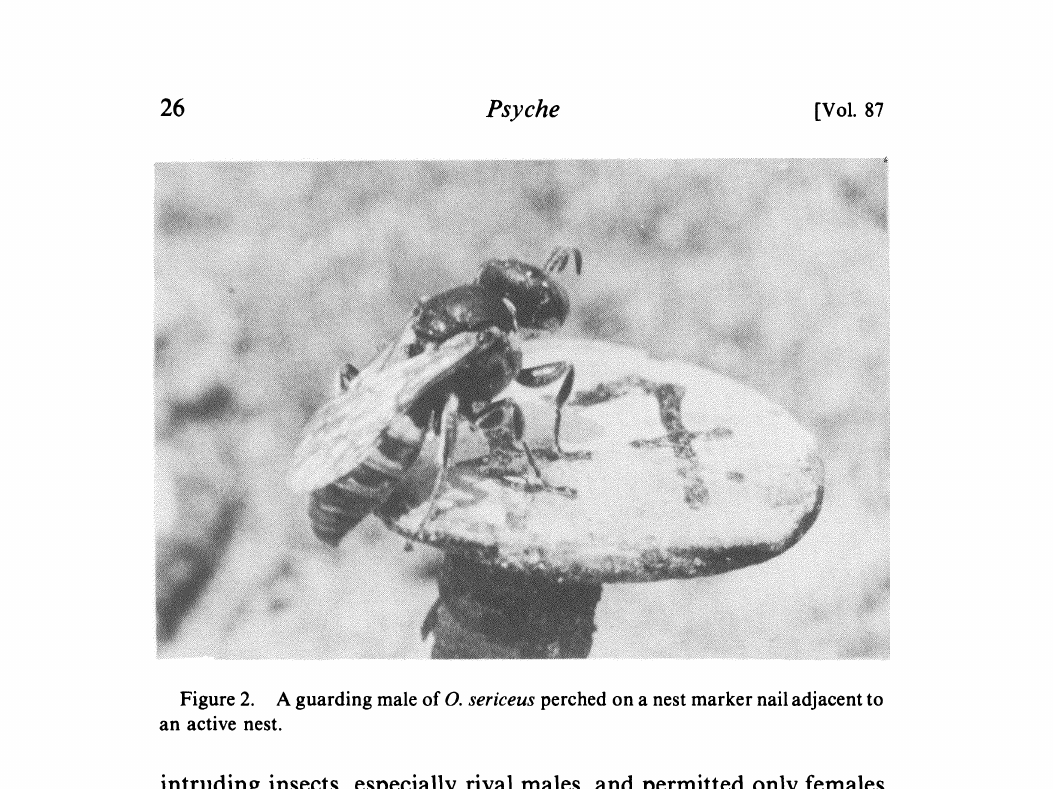
Figure 2. A guarding male of O. sericeus perched on a nest marker nail adjacent to an active